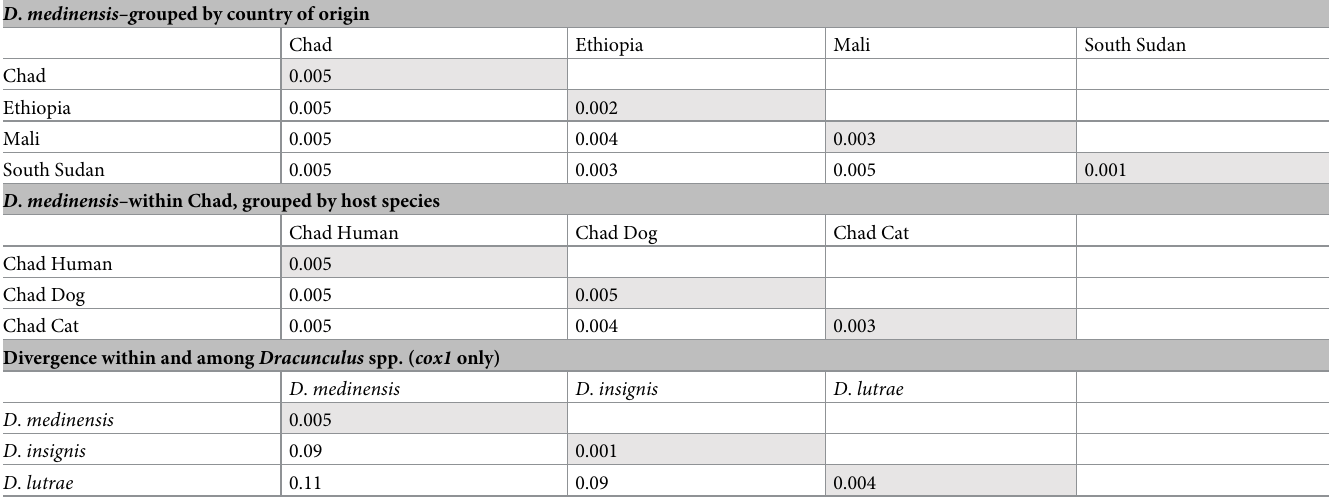
Table 2. Mean pairwise divergence ( p -distance) of mitochondrial lineages within and between dracunculid